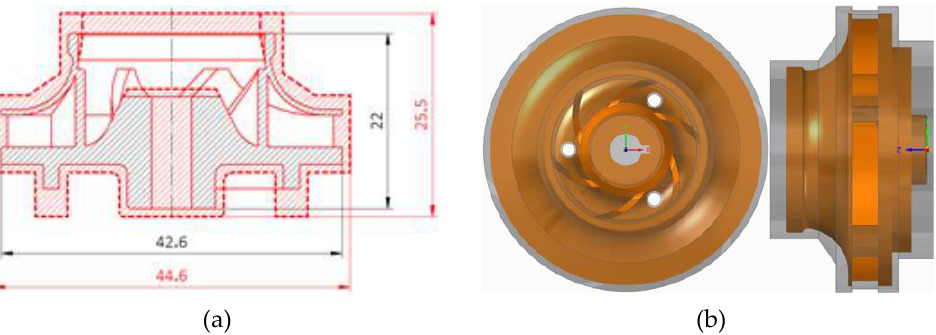
Figure 1. Schematic representation of ( a ) the closed impeller, where black area represents baseline model and red area represents AM model; top and side view of ( b ) the baseline model (orange) with offset material (gray).